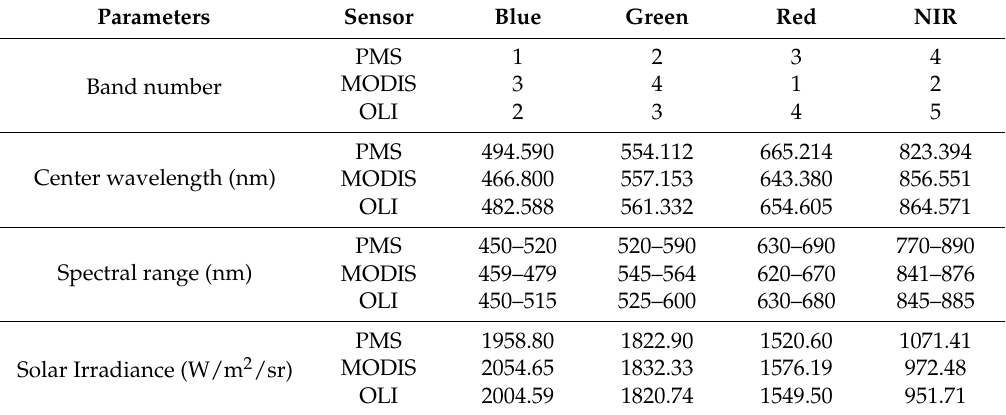
Table 1. Band number, center wavelength, spectral range, and solar irradiance of PMS, MODIS, and OLI.